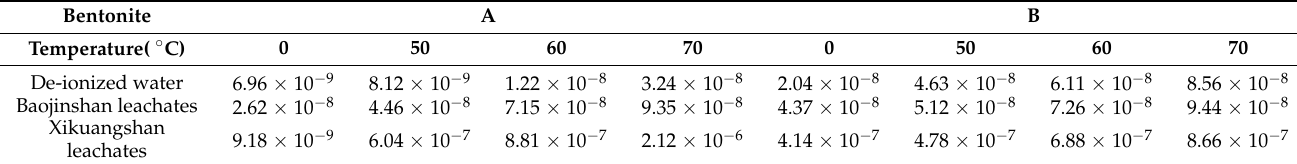
Table 5. Calculation value of permeability coefficient of bentonite at high temperature.